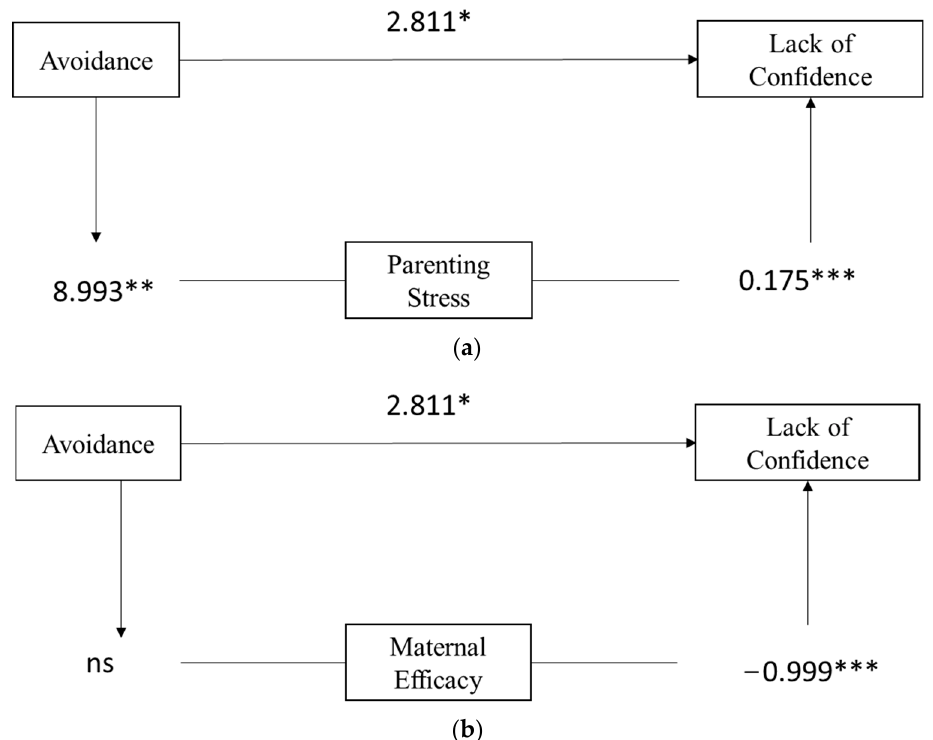
Figure 2. ( a ) Hp2. Path analysis with lack of confidence in caretaking as the outcome, parenting stress as the mediator, and adult attachment (avoidance dimension) as the predictor. * p < 0.05; ** p < 0.01; *** p < 0.001. ( b ) Hp3. Path analysis with lack of confidence in caretaking as the outcome, maternal efficacy as the mediator, and adult attachment (avoidance dimensions) as the predictor. * p < 0.05; ** p < 0.01; *** p < 0.001.